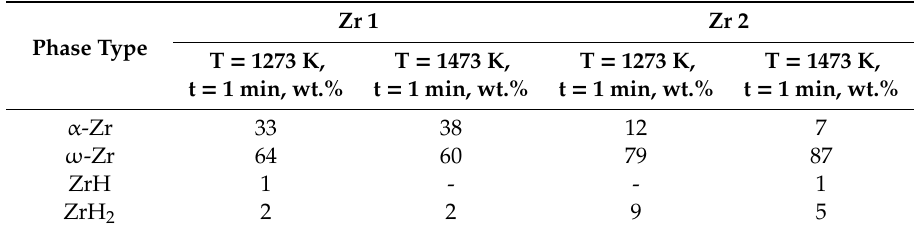
Table 5. The phase composition of the Zr 1 and Zr 2 sintered materials in 7.8 GPa depending on the temperature of the sintering